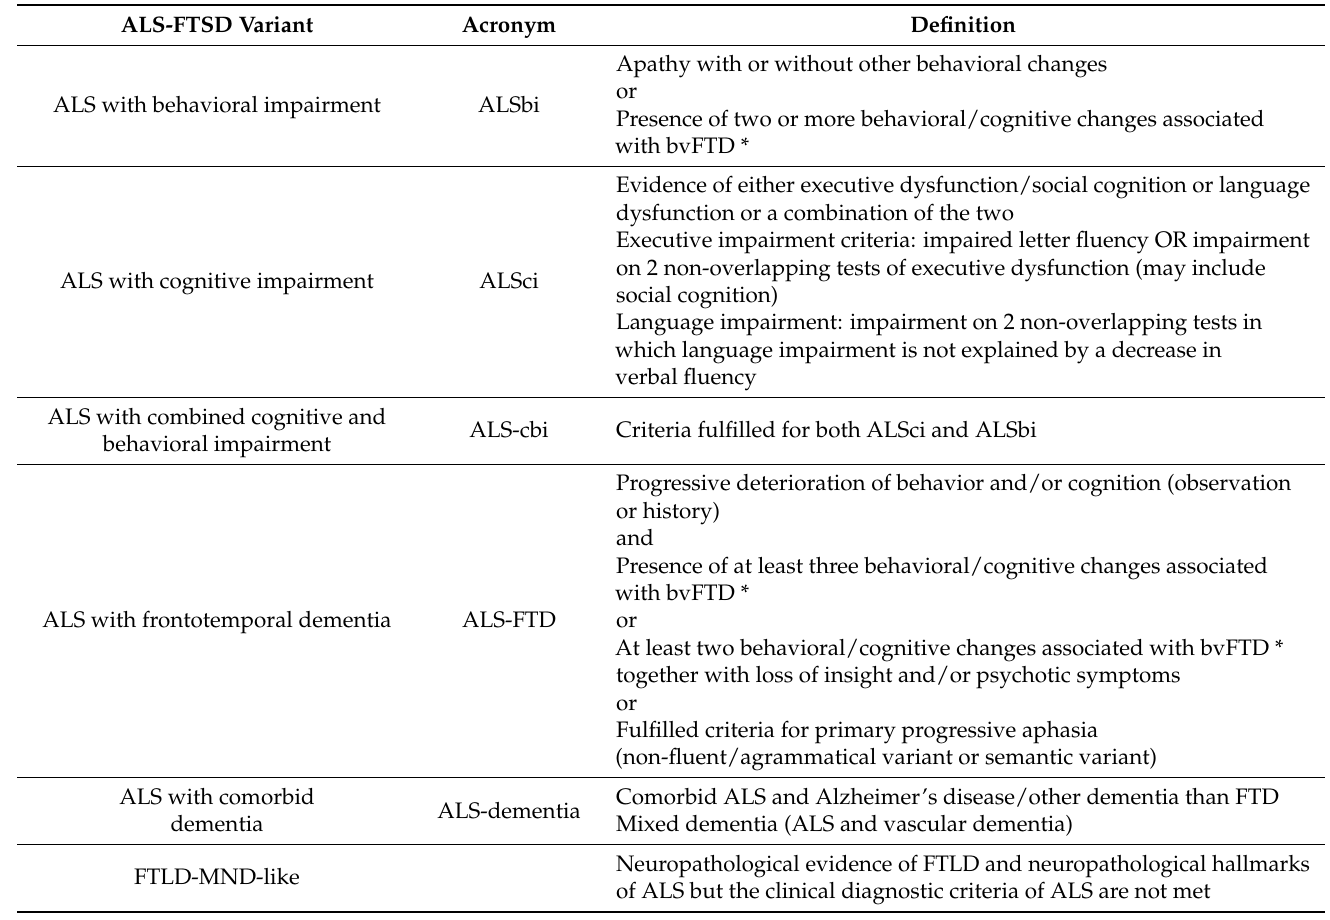
Table 1. Amyotrophic lateral sclerosis-frontotemporal spectrum disorder (ALS-FTSD) criteria for the diagnosis of cognitive and behavioral symptoms associated with ALS, modified following Strong et al.